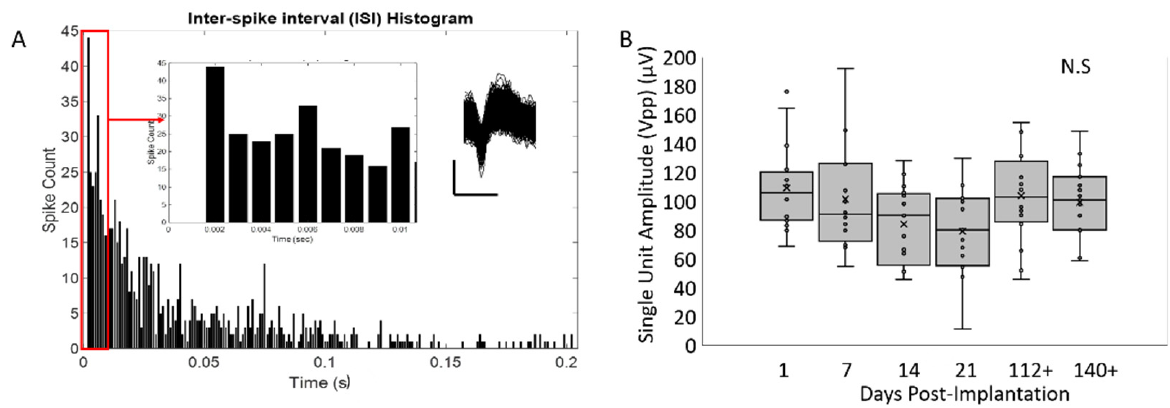
Figure 14. ( A ) ISI histogram of a single unit isolated from spontaneous neural activity after 5 months of implantation using a 16-electrode, Pt/Ir array. Bin size is 1 ms. Inset on the left shows a closeup of the histogram indicating no spikes in the refractory period. Inset on the right shows representative single unit waveforms isolated from a 2 min block of neural recordings. Vertical bar is 50 µ V and horizontal bar is 1 ms. ( B ) Plot of Vpp vs. implantation time for all 16 electrodes (Pt/Ir array) over 5 months shows no significant differences (N.S) in the largest single unit isolated from spontaneous activity in all 16 electrodes. For 3 week and 5 month time points, single units were not isolated. Mean is indicated with ‘ × ’ and individual electrode values are indicated by ‘ ◦ ’. Significance was assessed using one-way ANOVA ( α ~0.05).